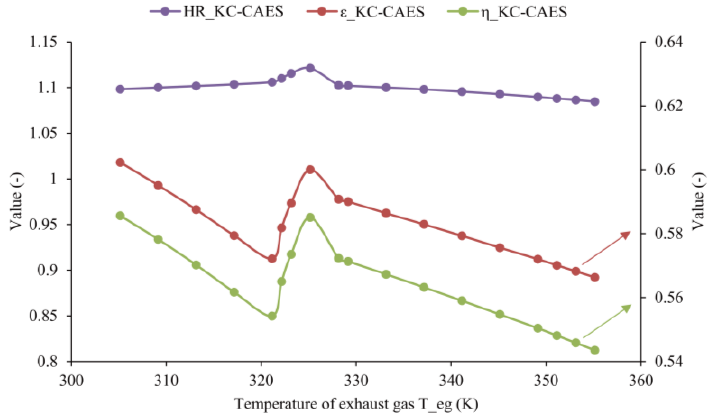
Figure 8. Effect of the outlet temperature of the exhaust gas on the performance parameters of the KC-CAES